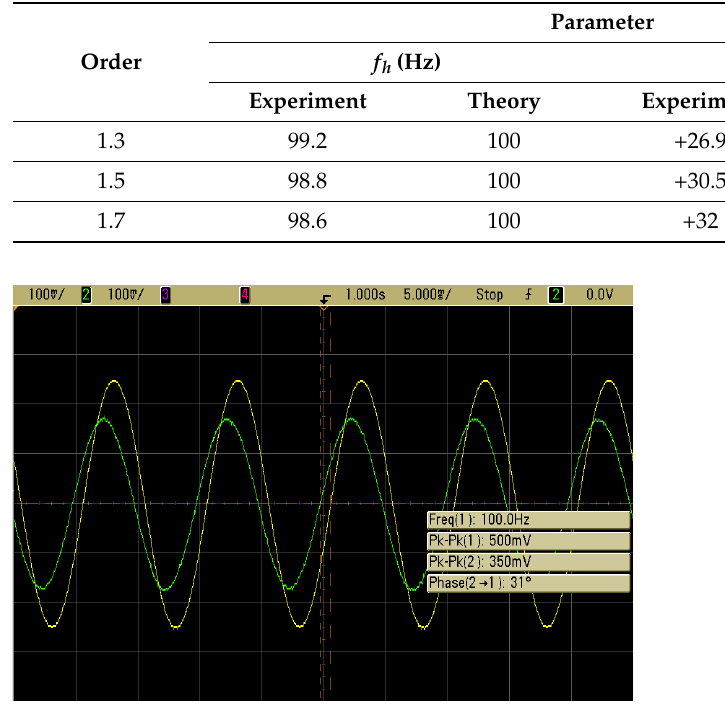
Figure 7. Experimental input and output waveforms of HP filter of order 0.5, stimulated by 0.5V, f = 100Hz sinusoidal signal.